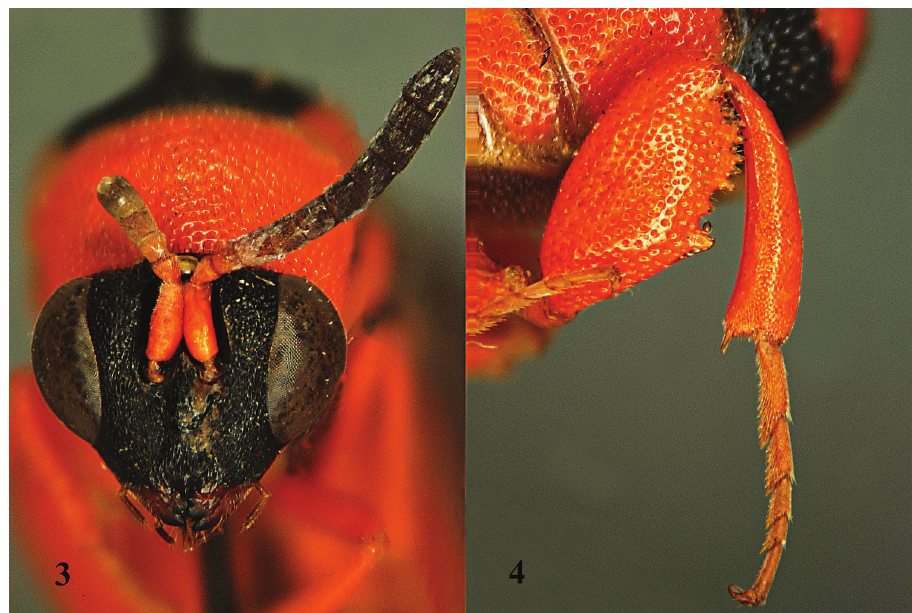
Figures 3–4. Leucospis aurantiaca Shestakov, ♀ , lectotype. 3 Head frontal 4 hind leg (courtesy of Mr. Paolo Rosa).